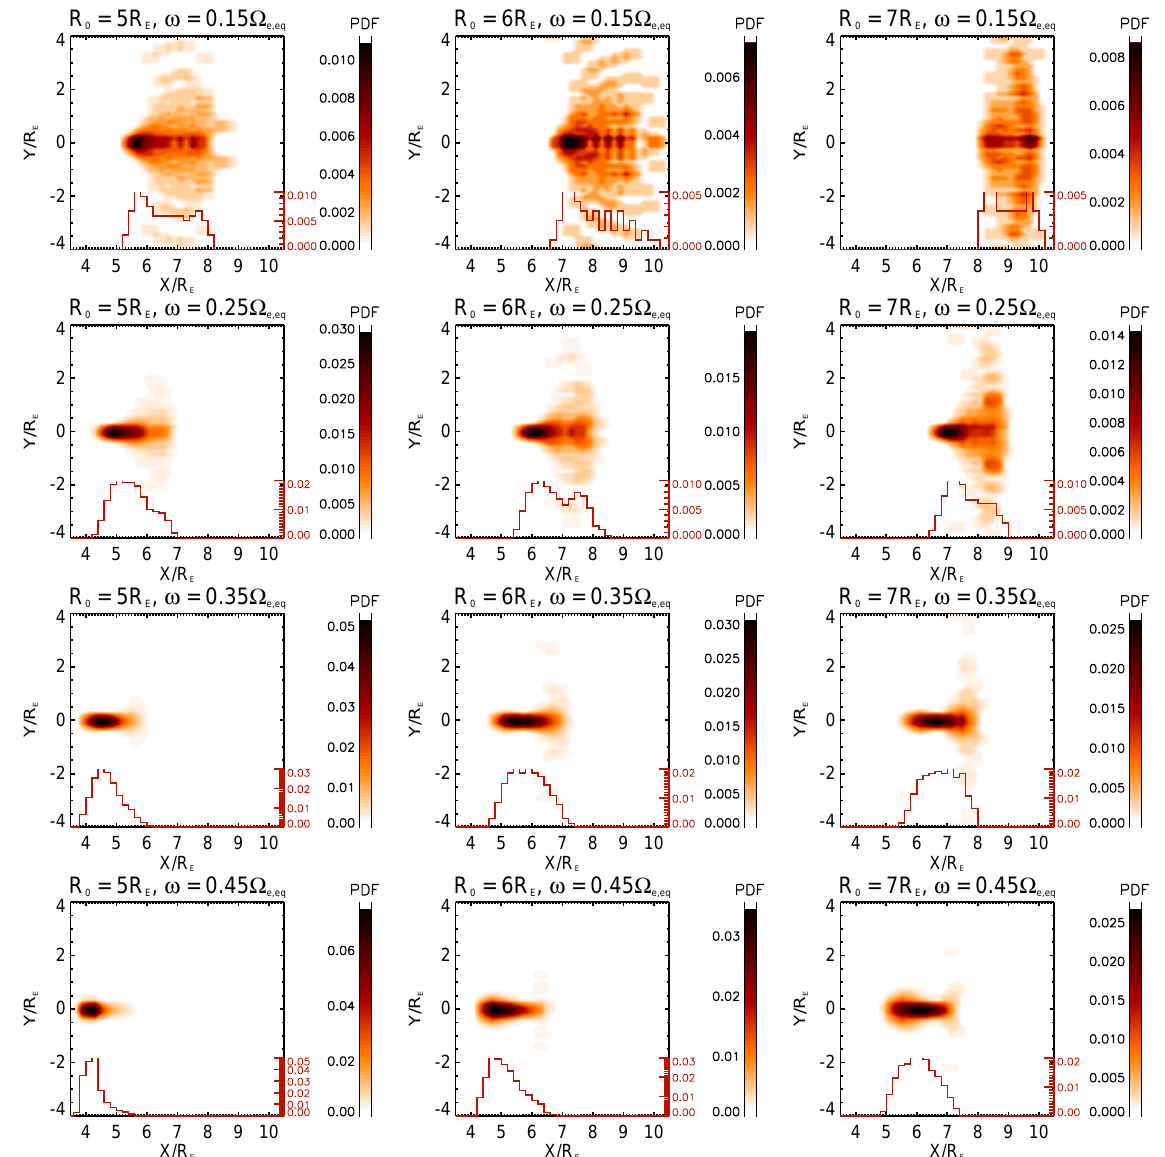
Fig. 1. The reflected wave power of selected “cones” of rays in the equatorial plane, after their first reflection at high latitudes. Each cone of rays consists of one selected frequency ω and one starting point R 0 , with polar and azimuthal wave normal angles in the ranges 0 ◦ ≤ θ 0 ≤ 40 ◦ and − 180 ◦ ≤ ϕ 0 ≤ 180 ◦ , respectively. The histogram (red) shows the cross section of the distribution along the x axis for Y ≈